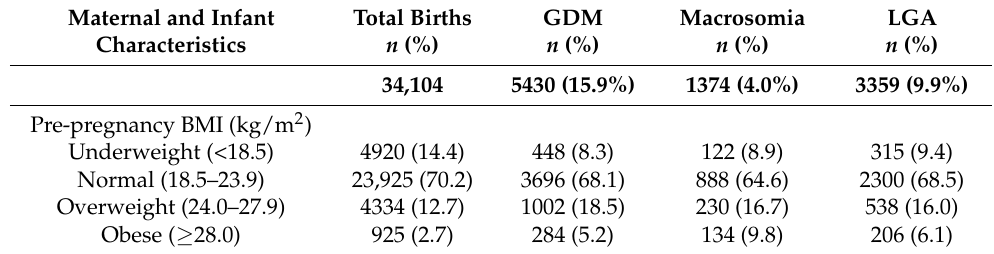
Table 1. Distribution of maternal and infant characteristics according to GDM, macrosomia, and LGA newborns in the study sample of singleton births ( n =